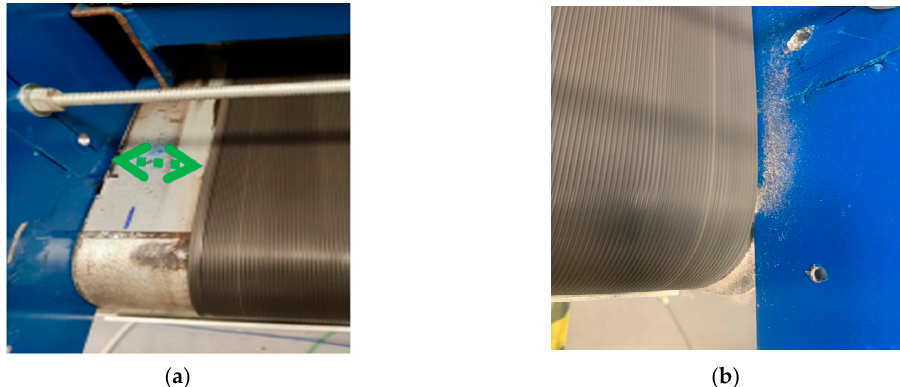
Figure 3. Normal belt tracking and belt mis-tracking conditions. ( a ) Normal belt tracking, drive side, no contact between the belt and the wall, ( b ) Non-drive side mis-tracking, the belt and the non-drive side wall are in contact.